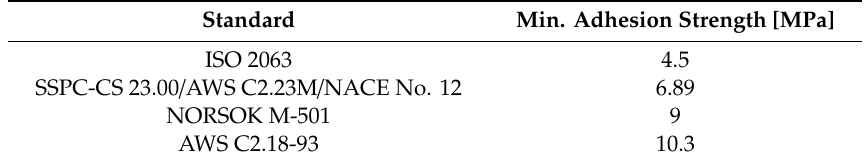
Table 1. Adhesion strength specifications for thermally-sprayed aluminium coatings in key